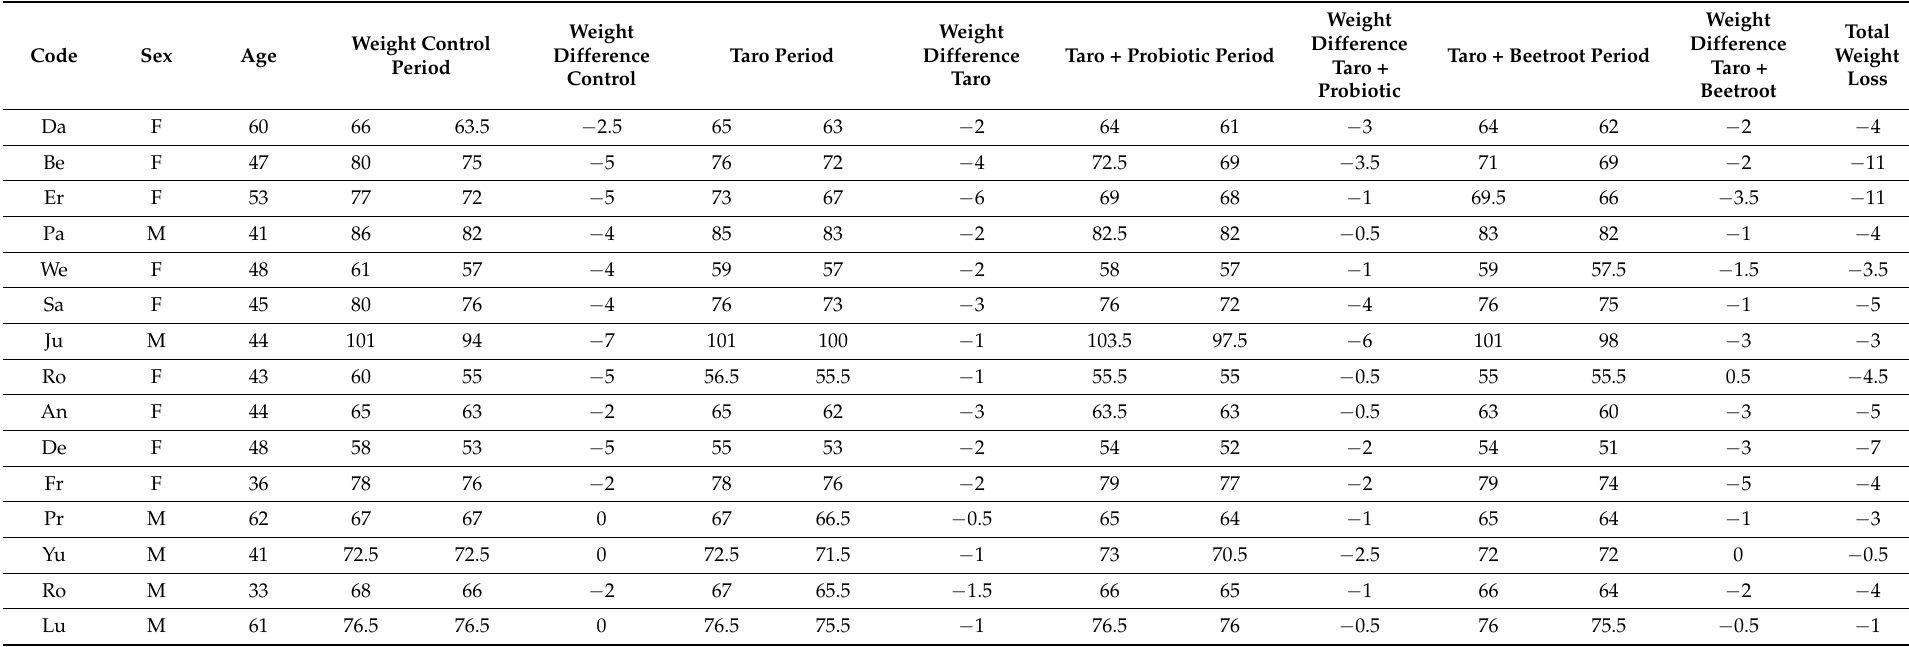
Table 1. Subject characteristics and weight loss in each individual period as well as the complete intervention